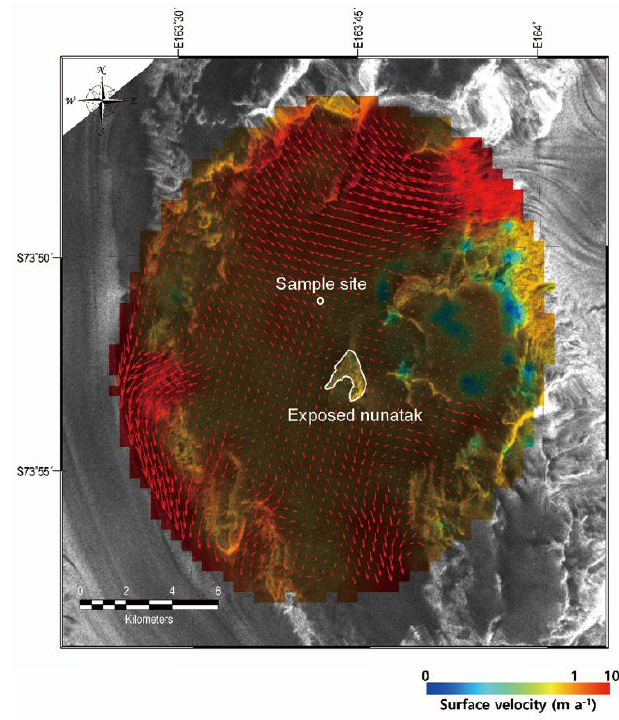
Figure 2. Ice surface velocity and flow direction (red arrows) around the drilling site, derived from satellite radar interferometry data [39] . The background is Sentinel-1 synthetic aperture radar image acquired on June 17, 2017.